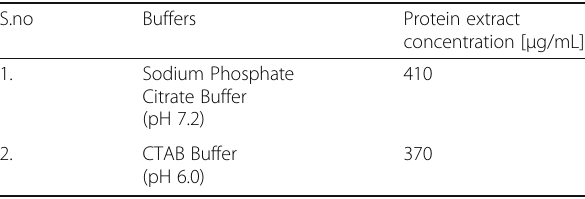
Table 3 Comparison of protein concentration (mcg/mL) after Ion-exchange